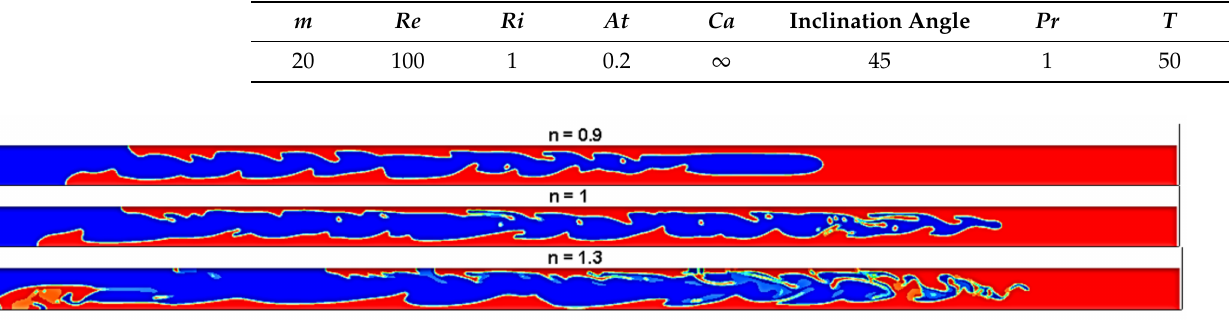
Table 1. Dimensionless numbers and parameters used in simulations.